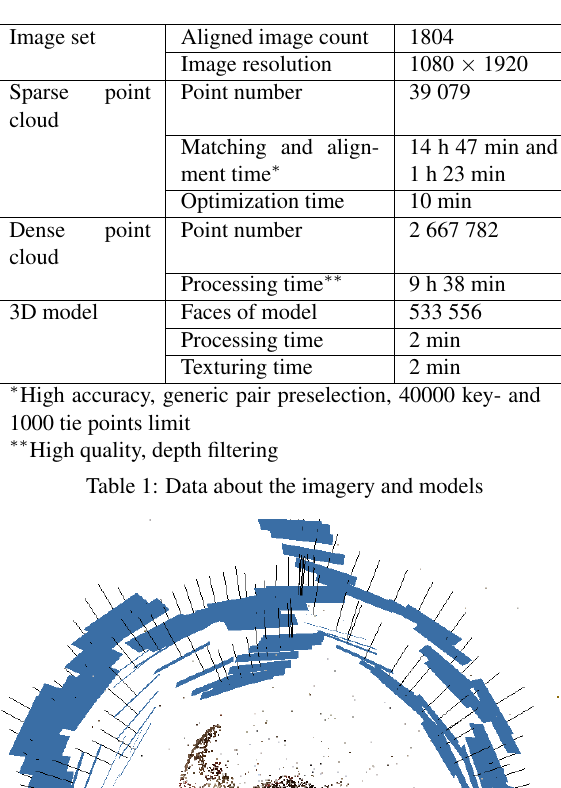
Figure 4: Overview of CT images, reliquary of the Madonna sculpture